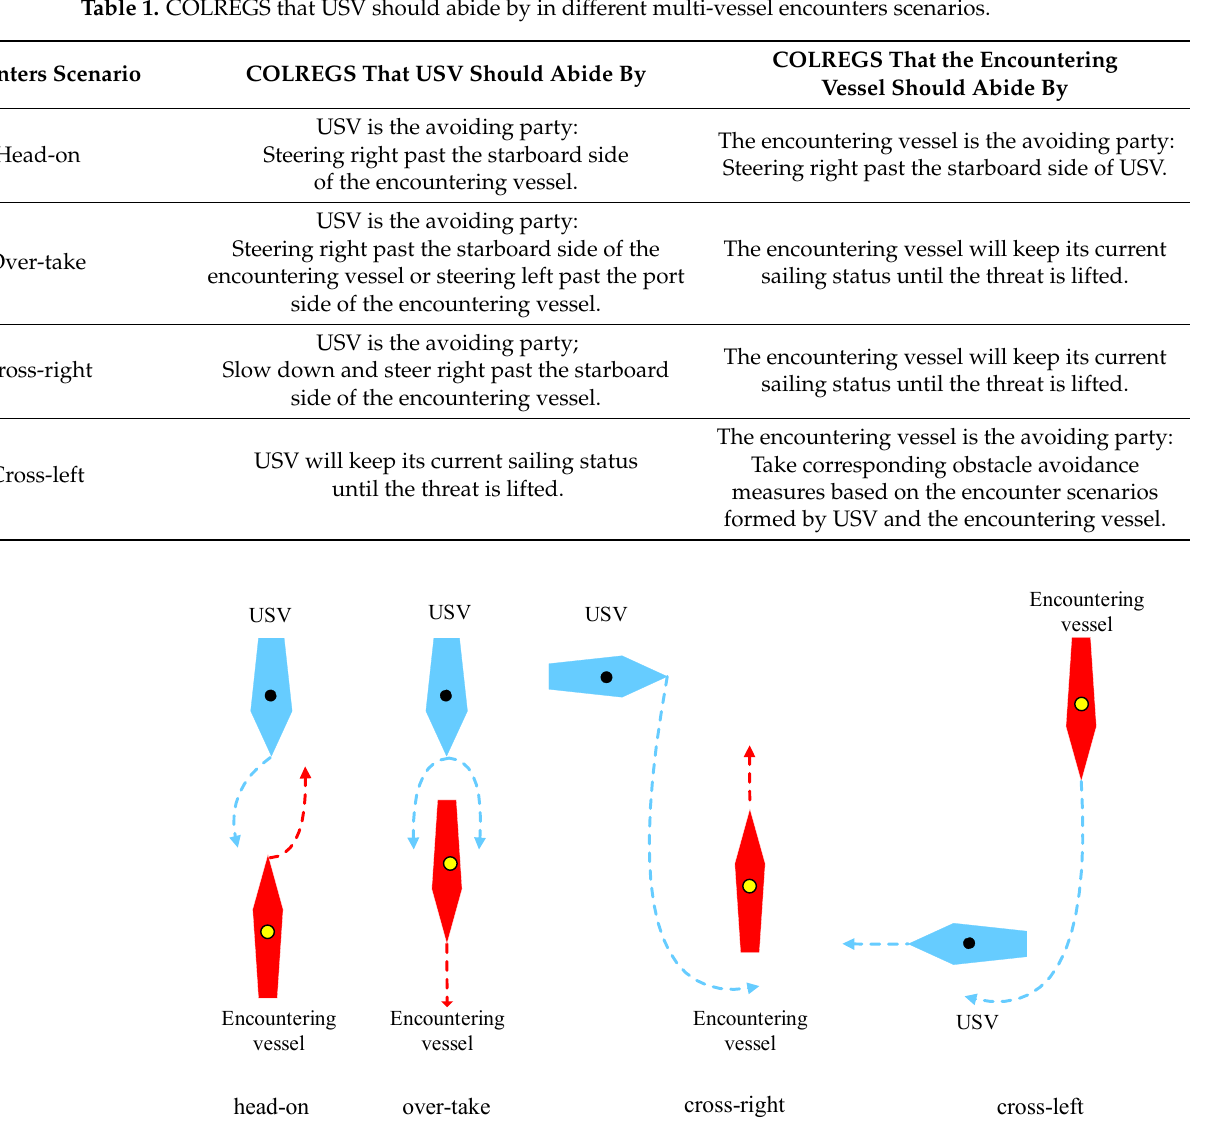
Table 1. COLREGS that USV should abide by in different multi-vessel encounters scenarios.